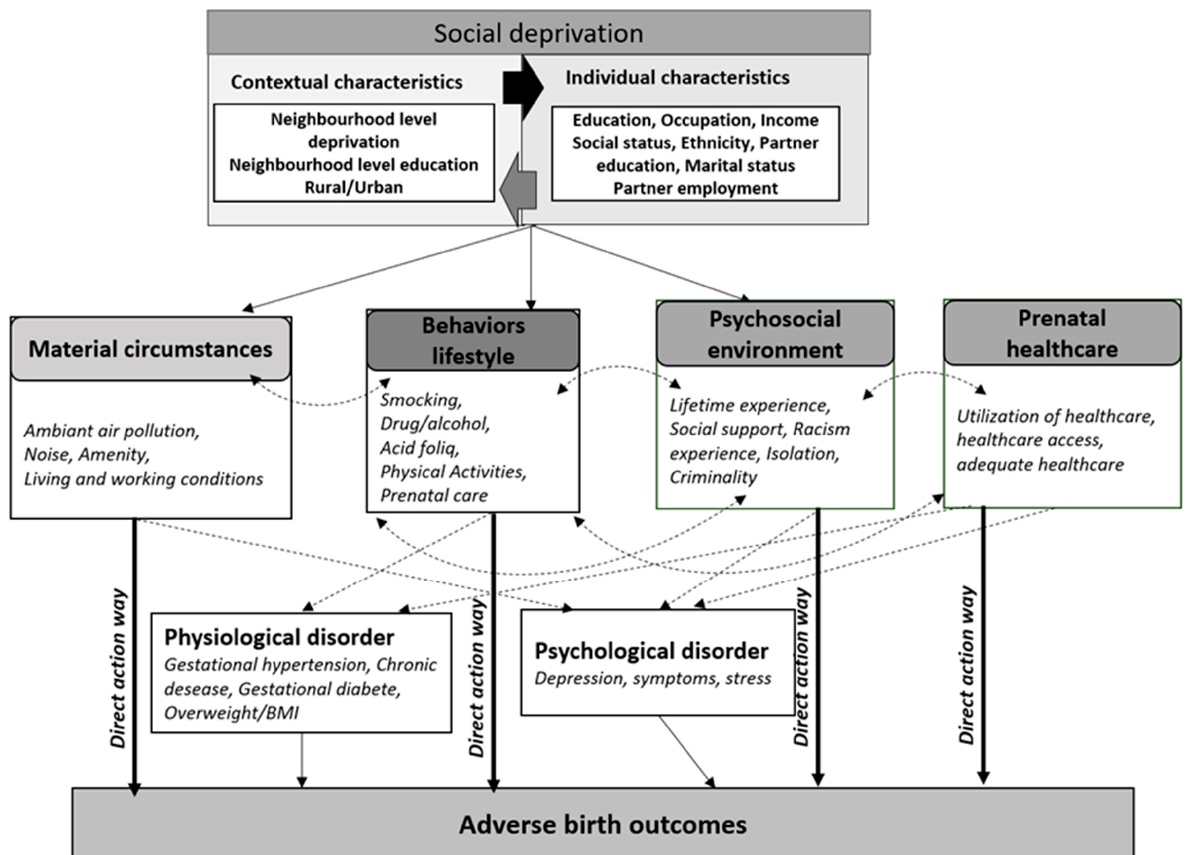
Figure 2. A conceptual model to explain the overlapping relationship between social deprivation (including individual and neighborhood level) and adverse birth outcomes. (including individual and neighborhood level) and adverse birth